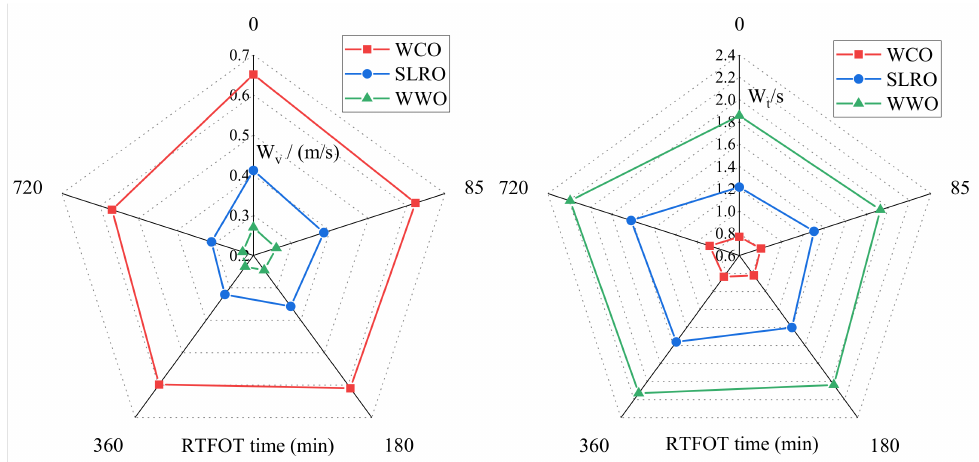
Figure 6. W v and W t varies with aging